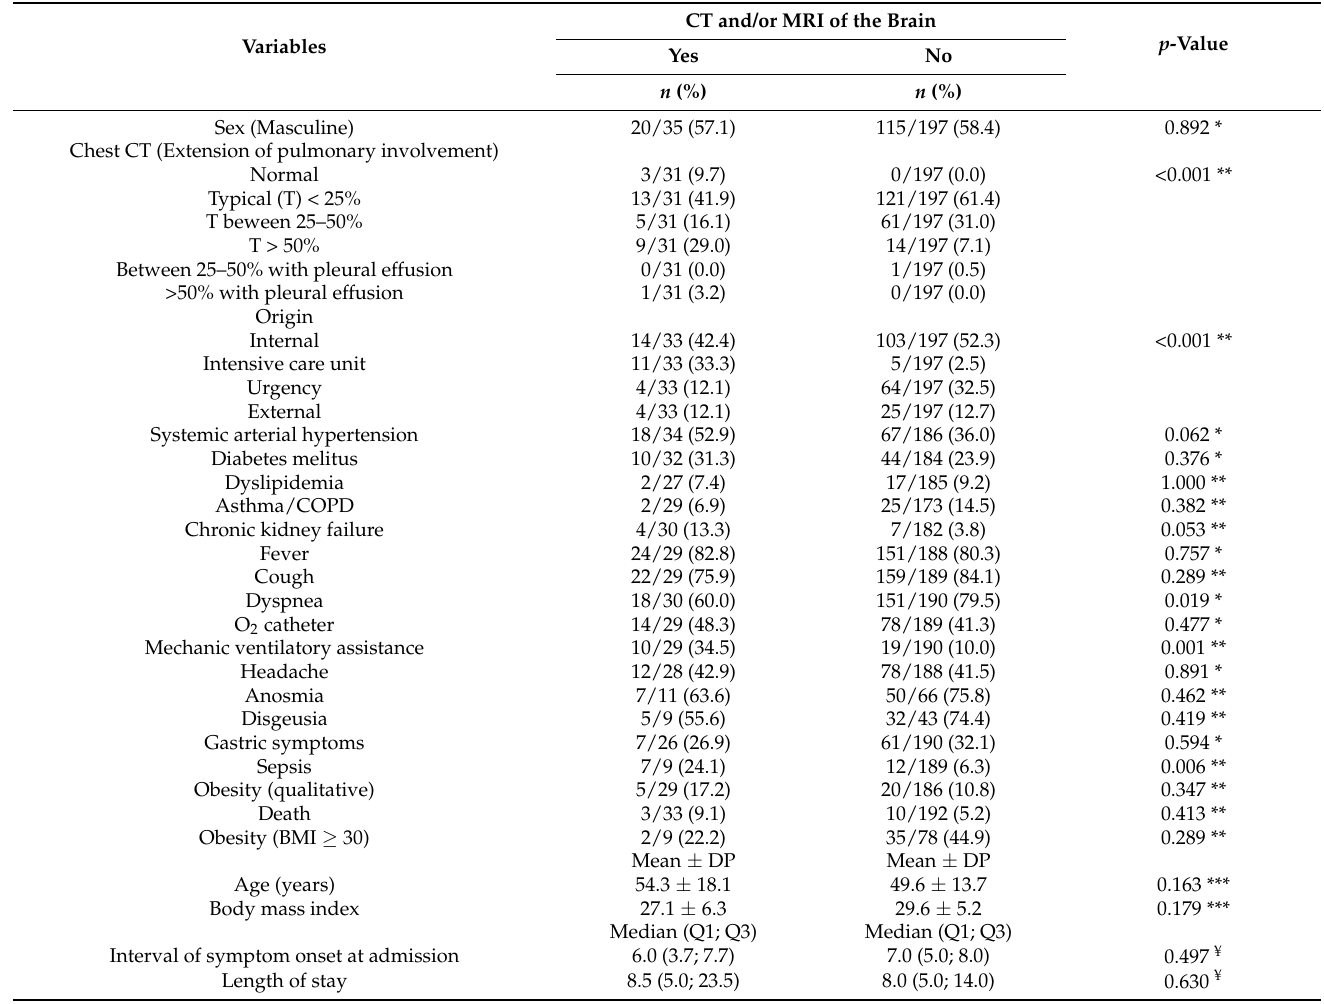
CT and/or MRI of the Brain